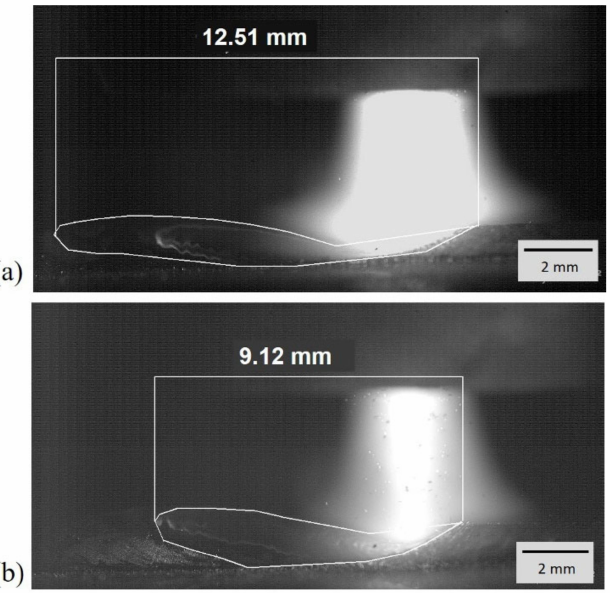
Figure 4. Weld pool size as a function of welding current at m P = 18.3 g/min. Powder mass flow and v s = 36 cm/min welding speed ( a ): I s = 105 A; ( b ): I s = 130